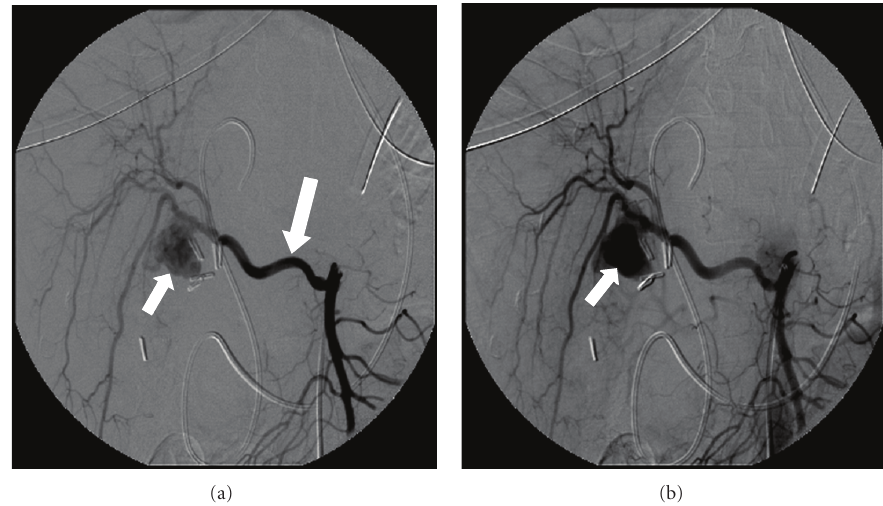
Figure 1: The angiogram shows the sac of a 2cm pseudoaneurysm, with no radiologic evidence of arterobiliary fistula. A few days before, the CT scan revealed a vascular lesion of 4mm, successively enlarging to the size reached at the moment of bleeding (smaller arrow). The pseudoaneurysm was located on a replaced right hepatic artery branching o ff the superior mesenteric artery (greater arrow).